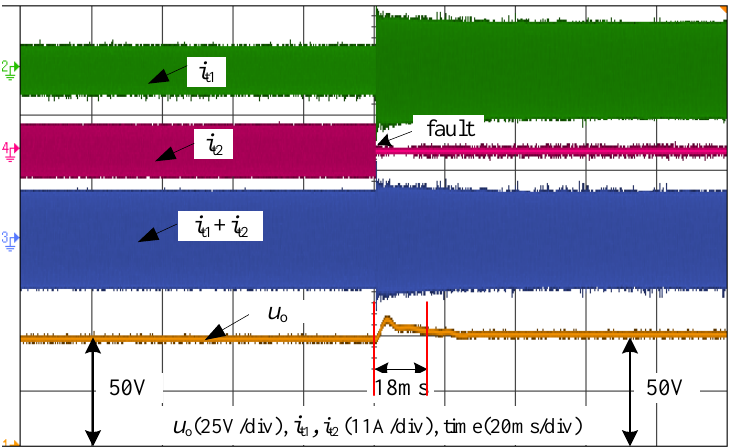
Figure 13. Dynamic tracking performance: ( a ) from 100 V to 80 V; ( b ) from 80 V to 100 V.